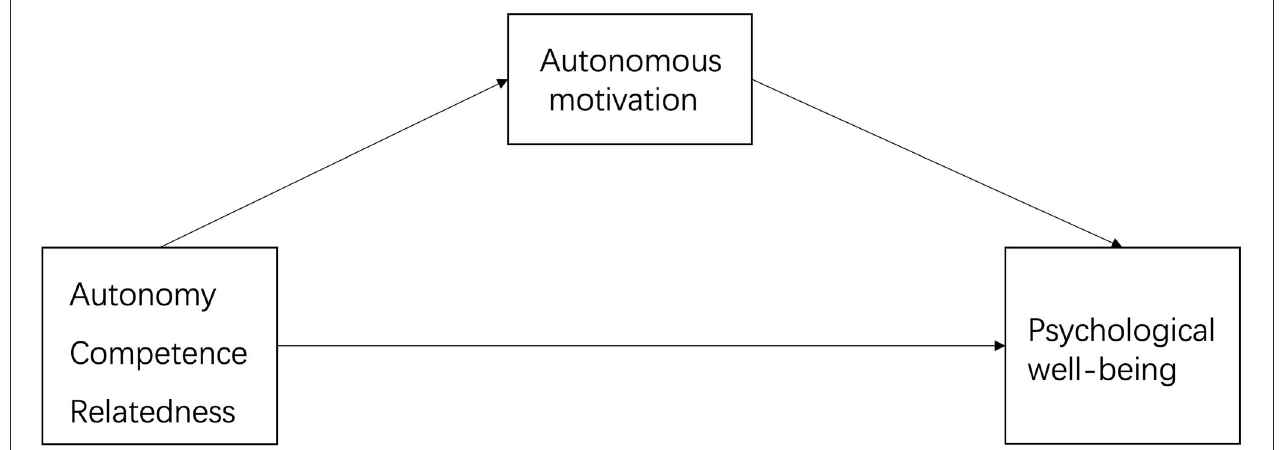
FIGURE 1 | Self-determination theory showing hypothesized relations between basic psychological need satisfaction, autonomous motivation, and psychological